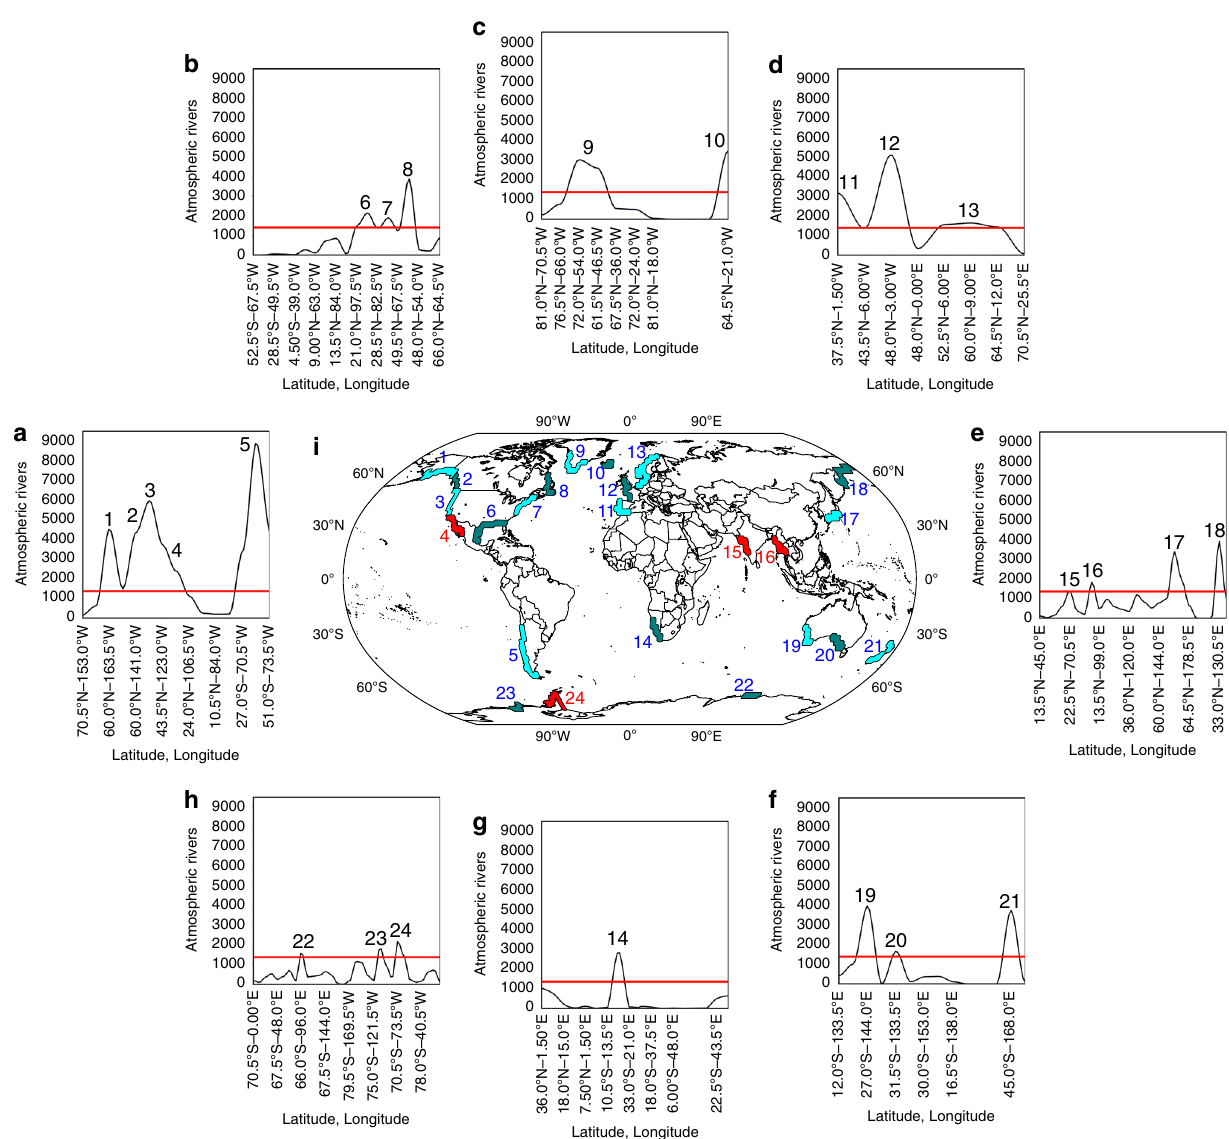
Fig. 1 Regions of maximum occurrence of landfalling Atmospheric River. Atmospheric Rivers (ARs) frequency over global coastal areas for the period 1980 – 2017 for: American West Coast ( a ), American East Coast ( b ), Greenland and Iceland ( c ), European West Coast ( d ), Asian Coast ( e ), Australian Coast and New Zealand ( f ), African Coast ( g ), and Antarctic Coast ( h ). The black line shows the number of ARs against coastal longitude and latitude. The red line represents the threshold of 10% of days computed considering all regions. i Global map showing the 24 landfalling Atmospheric River (LAR) regions detected (those not used for the remaining if the study of anomalous moisture uptake are shown in